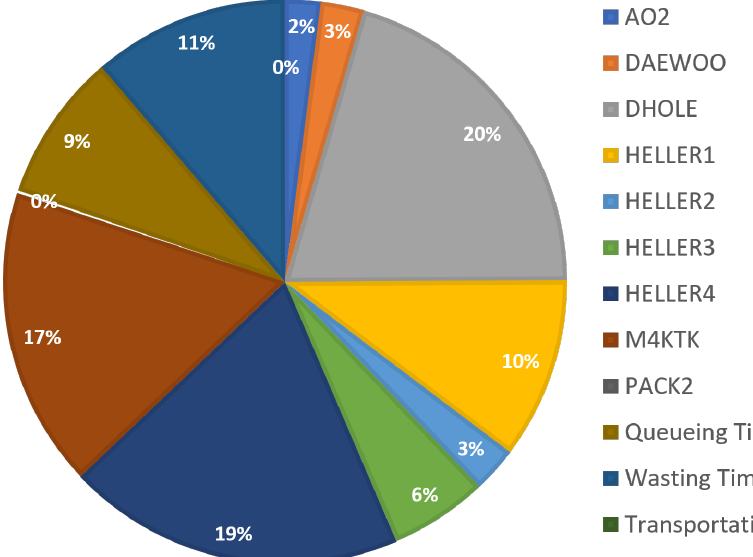
Figure 7. The distribution of the average times calculated based on the IPS and MES data. Table 2. The cycle and queueing times calculated with the help of the positional data.